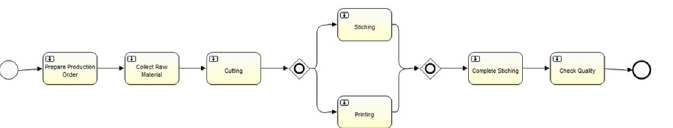
Fig 11. Generated BPMN model for shirt manufacturing, for both Simul8 and BPSimulator model generated BPMN is same.